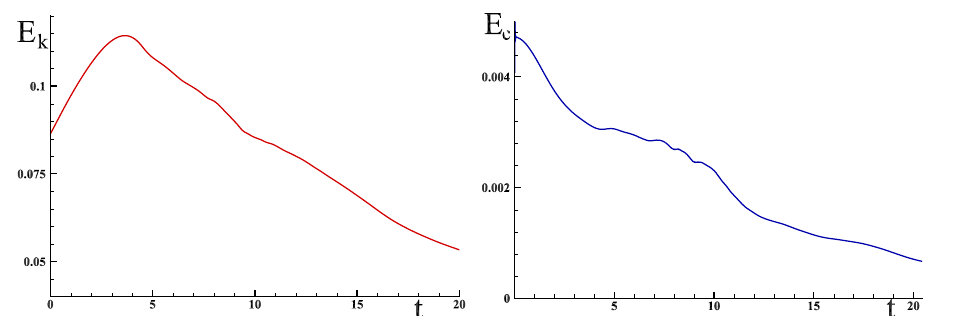
Figure 7. Global kinetic energy E k and compression energy E c at Reynolds number Re = 1600 for n c = 256 3 cells and n e ≈ 50 × 10 6 unknowns.